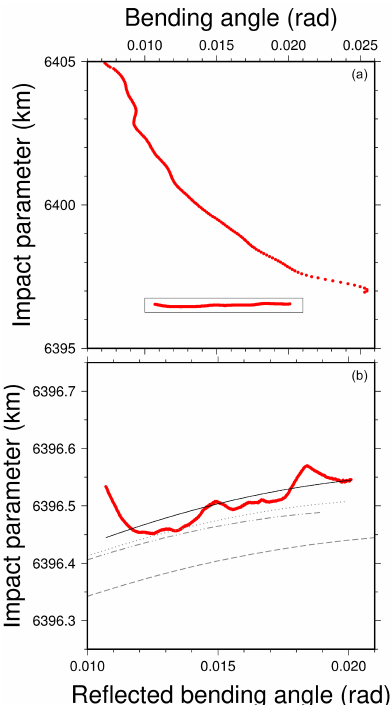
Figure 10. Profile of an (a) extracted bending and impact param- eter, including the standard direct branch, as well as the reflected, from the same occultation in Fig. 2. The box around the reflected branch is zoomed in (b) . The reflection was extracted as detailed in Sect. 4 (thick red). A parabolic fit to it is shown in solid black. The COSMIC Data Analysis and Archival Center (CDAAC) also offers profiles of refractivity N(h) , which allow the evaluation of the ex- pected α R and a using Eq. (3). These are shown in grey, using re- fractivity obtained from the direct data (atmPrf file, dashed-dotted), from a background NWP (ecmPrf file, dashed), and from a 1-DVar estimation (wetPrf file,